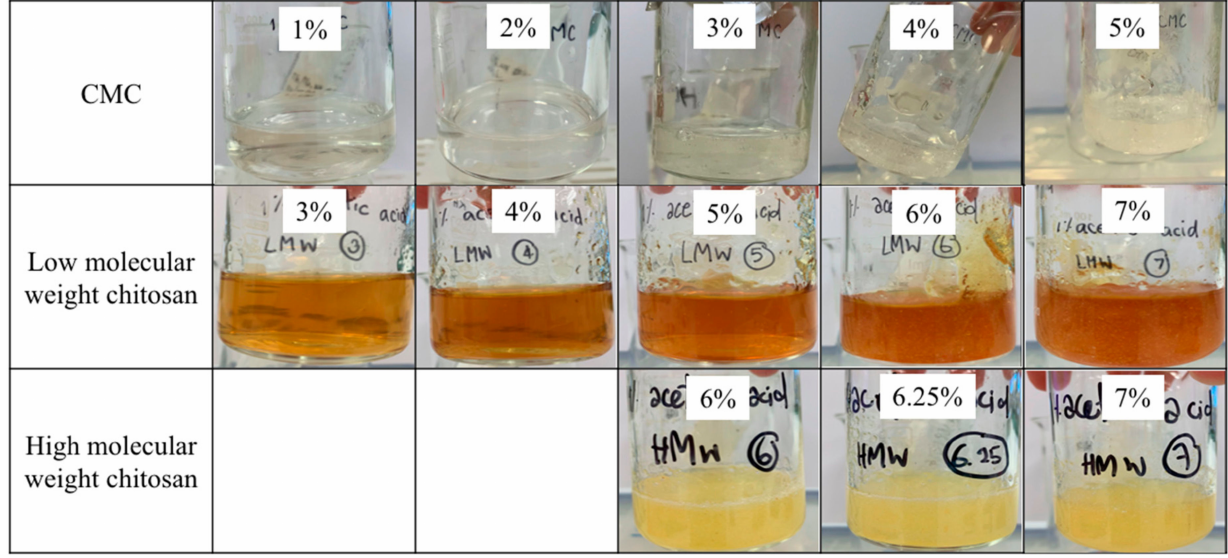
Figure 1. Physical appearance of the gels prepared from different concentrations of carboxymethyl cellulose (CMC), low molecular weight chitosan, and high molecular weight chitosan.